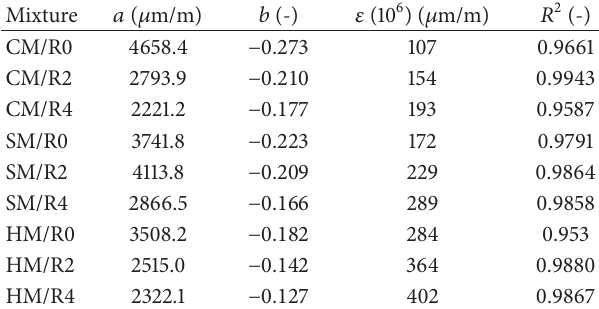
Table 5: Regression coefficients of the fatigue curves: 𝑁 𝑓 approach for unaged mixtures.